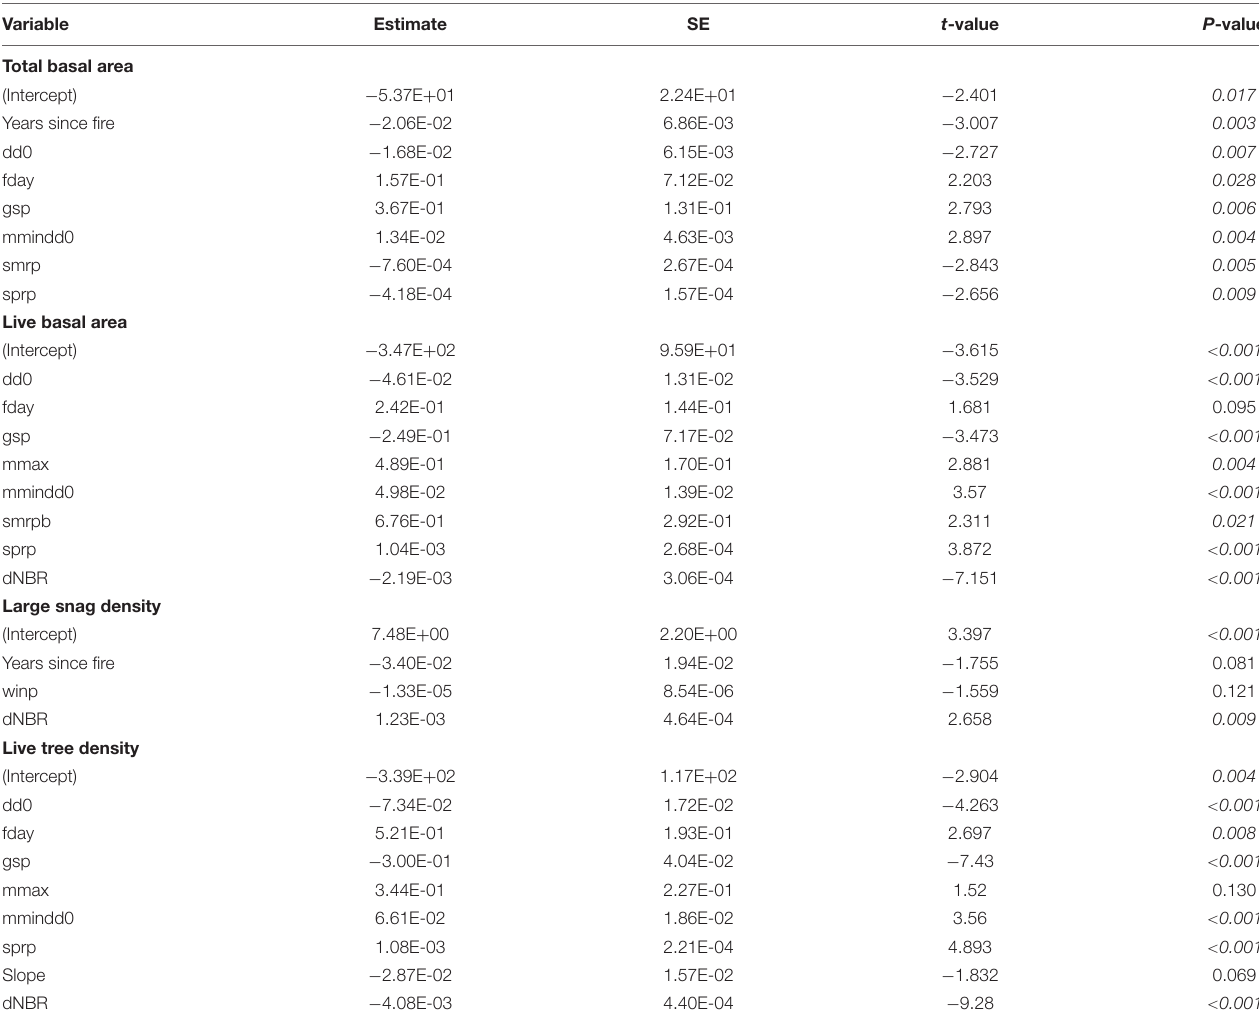
TABLE 4 | Results of generalized linear models (GLM) of site climate variables, topography, years since fire, and severity (dNBR) to predict total basal area, live basal area, large snag density, and live tree